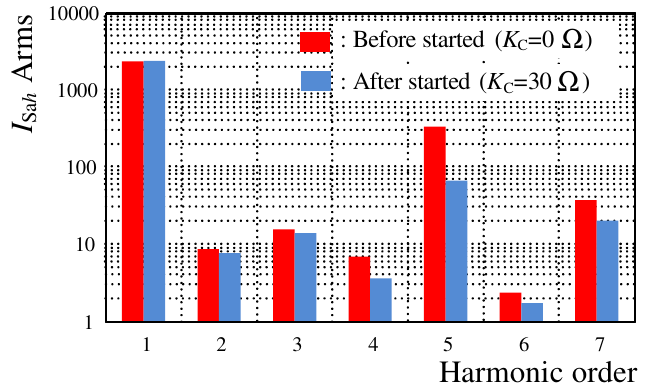
Figure 10. Spectra of a-phase source current i Sa .